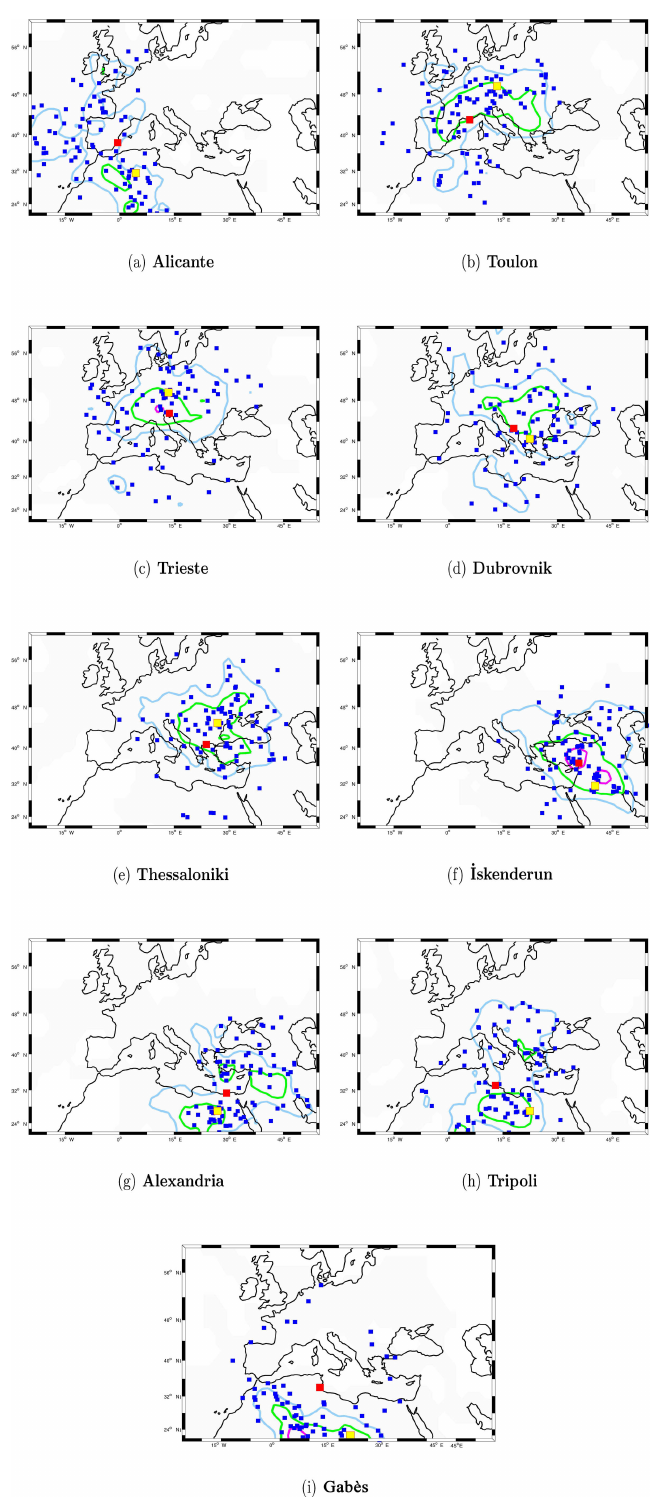
Figure 8. The same as Fig. 6, except referring to large negative sea level anomalies, the presence of anticyclones and Table 4.